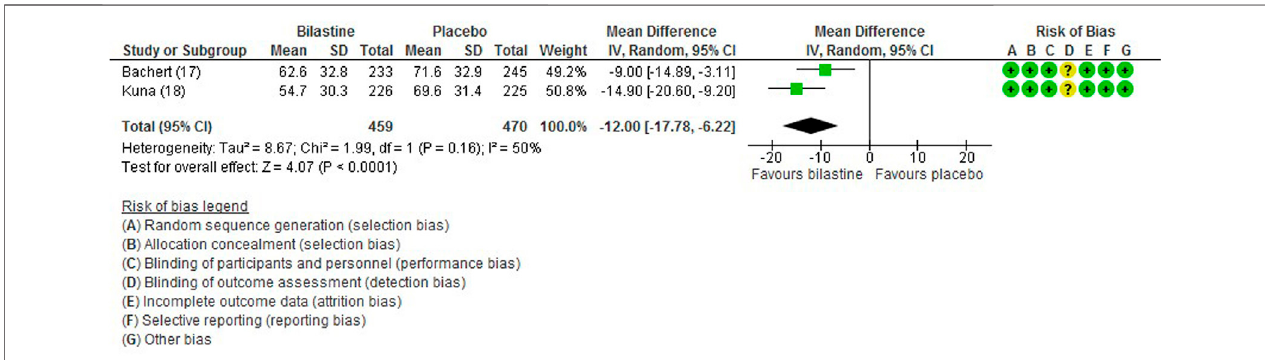
Frontiers in Pharmacology |